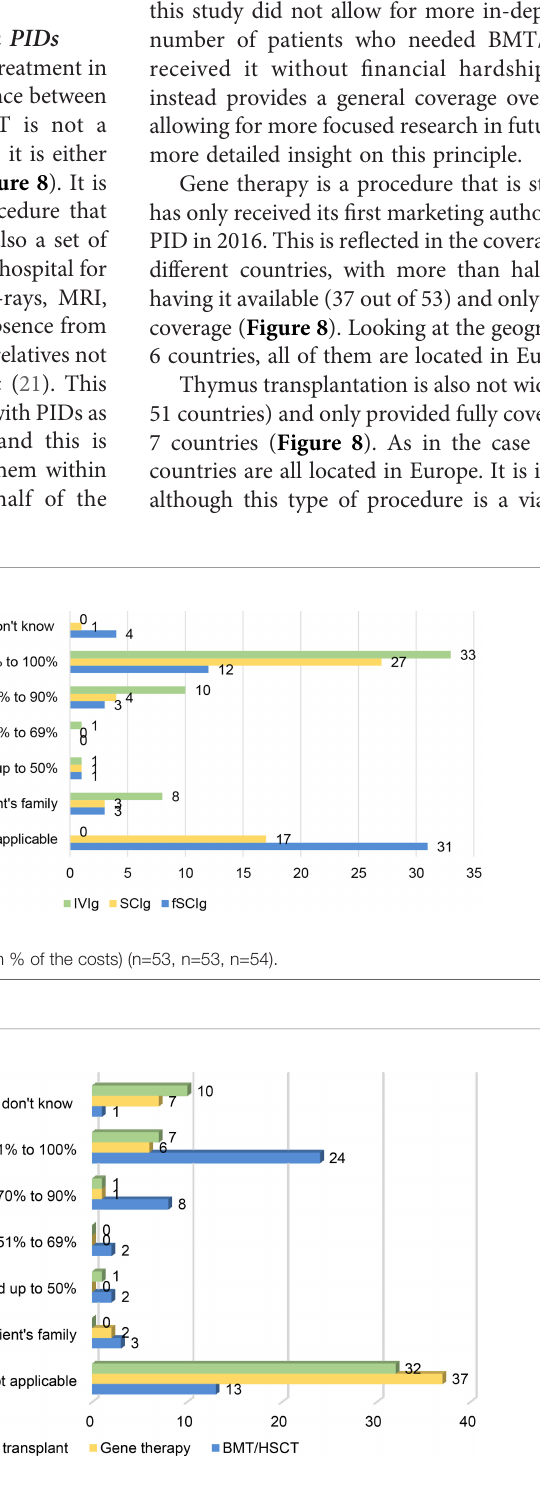
FIGURE 8 | Coverage of the different curative treatments for patients with PIDs (in % of the costs) (BMT/HSCT n=53, Gene therapy n=53, Thymus transplant